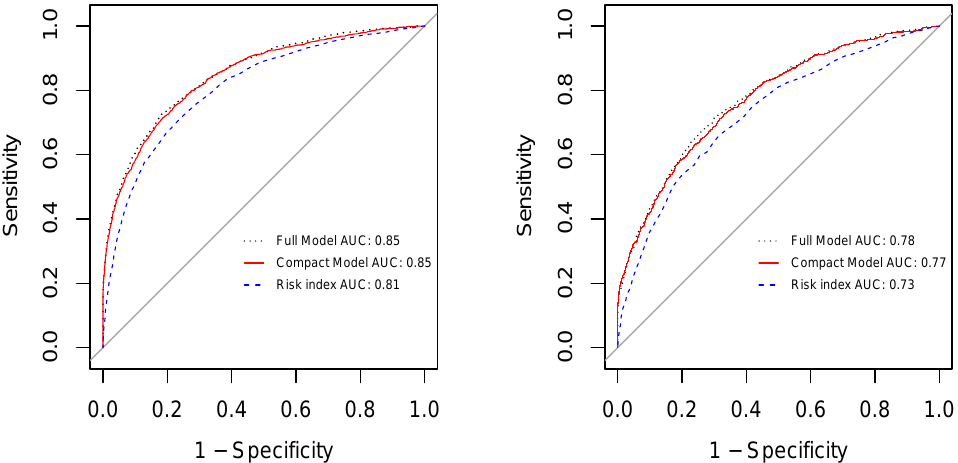
Figure 5. AUCs on the derivation cohort ( left ) and the validation cohort ( right